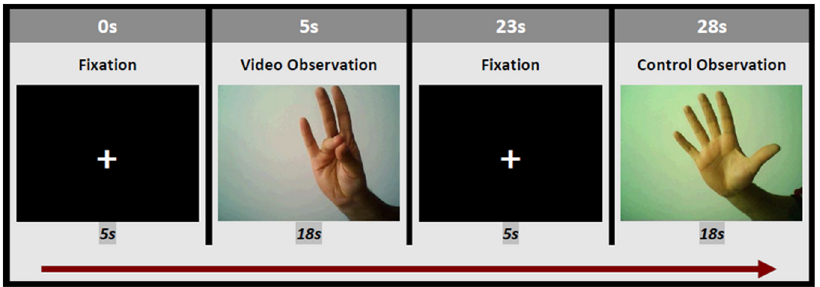
Figure 2. Scheme of the block design with the time onset of each condition. A total of 16 blocks were conducted (4 per finger). The upper row indicates the onset of each stage within the block. Video and control observation both lasted 18 seconds and Cross Fixation lasted 5